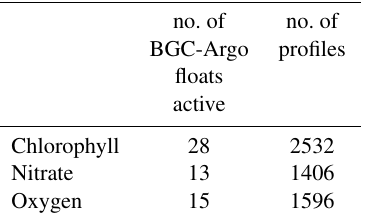
Table 1. Synthesis of the BGC-Argo floats dataset for the Mediter- ranean Sea used in the present study for chlorophyll, nitrate, and oxygen. no.